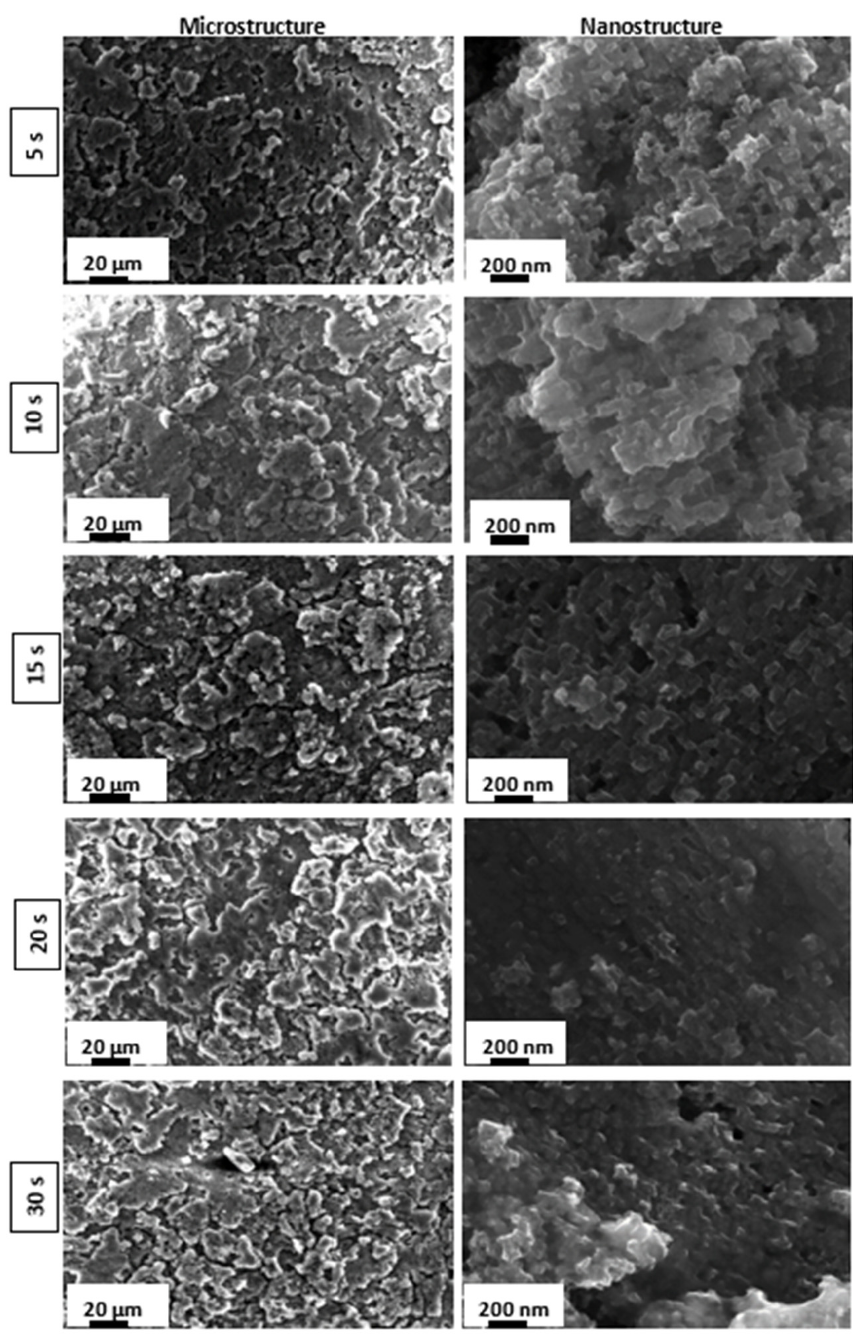
Figure 2. SEM images of superhydrophobic surfaces prepared by etching at different times.